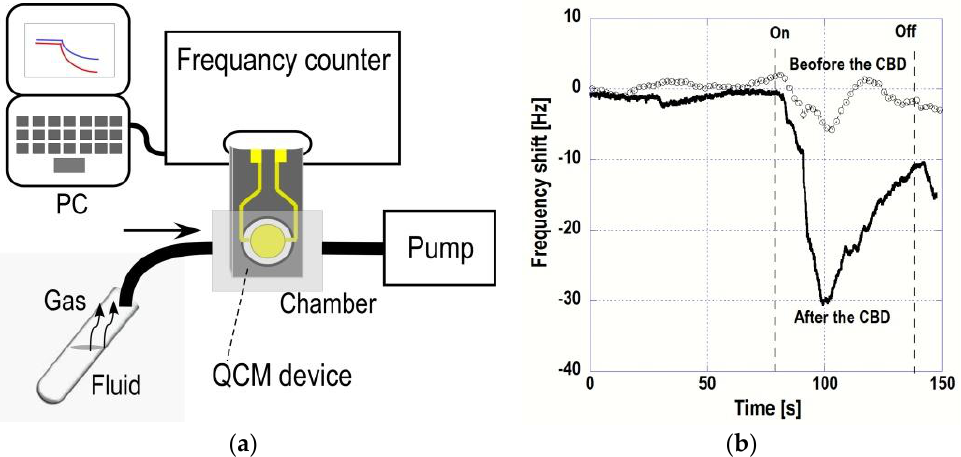
Figure 2. Left: ( a ) Schematic figure of QCM measurement for EtOH gas. Liquid EtOH was stored in a 1.5 mL microtube. After a cap of the microtube was opened, a silicone tube was inserted in the top of the microtube. Then, vapor of the EtOH gas was supplied to a measurement chamber by pump. Right: ( b ) Time dependent QCM measurements of EtOH gas before and after the CBD for 15 min.